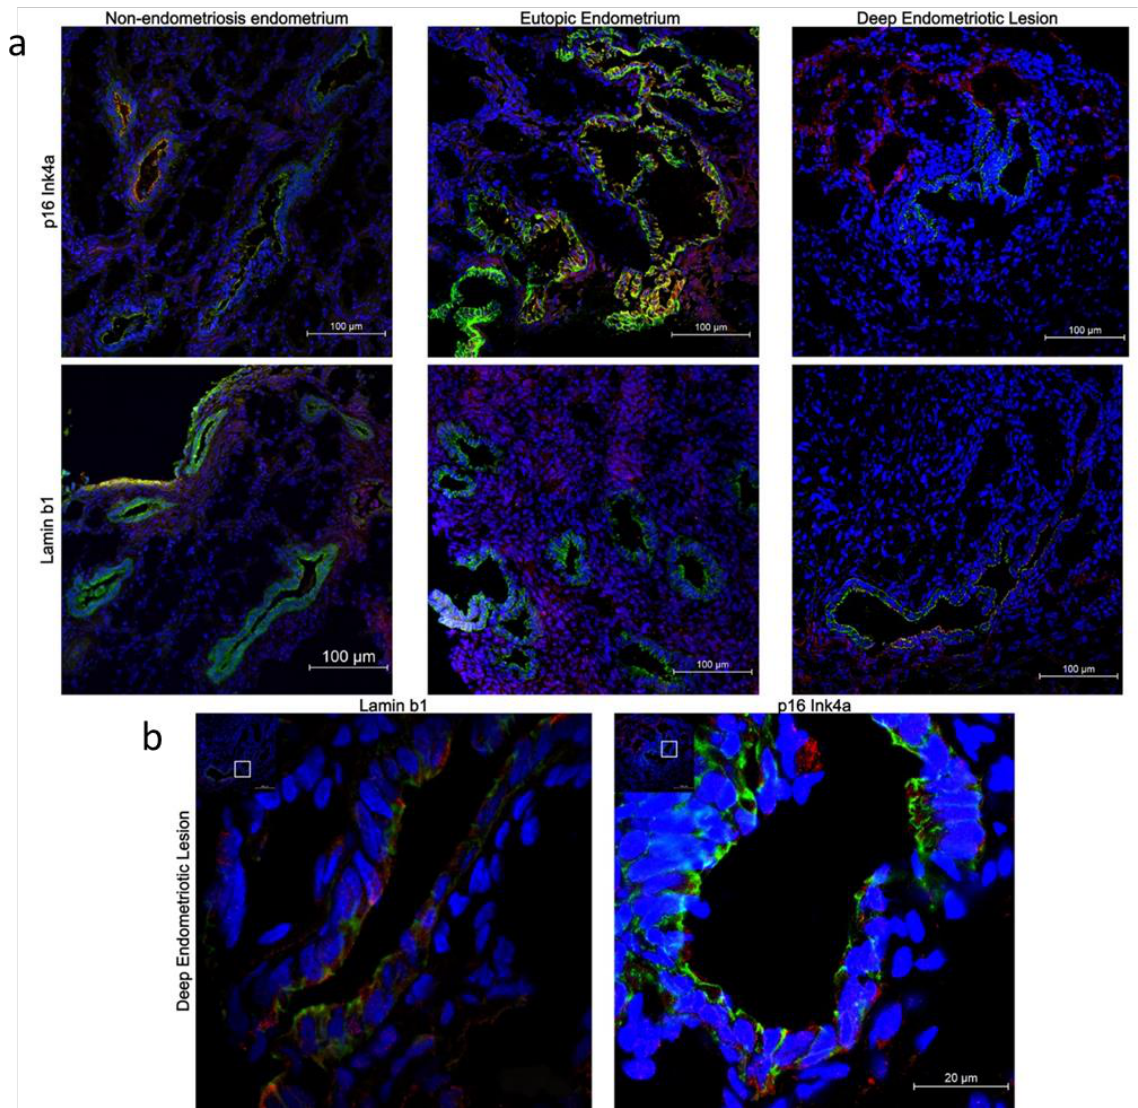
Figure 2. ( a ) Representative images of endometriosis and non-endometriosis tissues co-stained with p16 Ink4a or lamin b1 and e-cadherin (epithelial cell marker). p16 Ink4a and anti-lamin b1 are shown in red, e-cadherin in green, and the blue color (DAPI —4′,6 -diamidino-2-phenylindole) marks the cell nuclei. (i) non-endometriosis endometrium; (ii) eutopic endometrium; (iii) endometriosis lesions. Pictures were acquired at 20× magnification. ( b ) Representative images of p16 Ink4a and ( c ) lamin b1 co-stained with e-cadherin in deep endometriosis lesion tissues. p16 Ink4a and anti-lamin b1 are shown in red, e-cadherin in green, and the blue color (DAPI —4′,6 -diamidino-2-phenylindole) marks the cell nuclei. The red arrow shows cells that are only stained for p16 Ink4a or lamin b1, and the yellow star shows epithelial cells stained for both p16 Ink4a and lamin b1. Pictures were acquired at 20× and 100× magnifications. 2.5. Inflammatory Cytokine Expression in Endometriosis Lesions was Lower than that in Eutopic Endometrium in the Secretory and Proliferative Phases Expression of cytokines IL-2, IL-6, IL-10, and IL-15 was lower in endometriosis le- sions than in eutopic endometrium in the secretory phase (Figure 3). IL- 1β, IL -6, and IL- 15 expressions were lower, and IL-4 was higher in endometriosis lesions compared to that in eutopic endometrium in the proliferative phase (Figure 3). However, no difference was